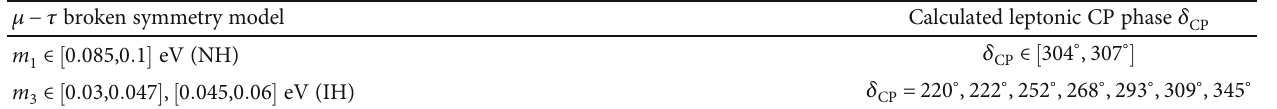
Table 1: Values of the δ phase giving correct updated values of baryon asymmetry. CP μ − τ broken symmetry model Calculated leptonic CP phase δ